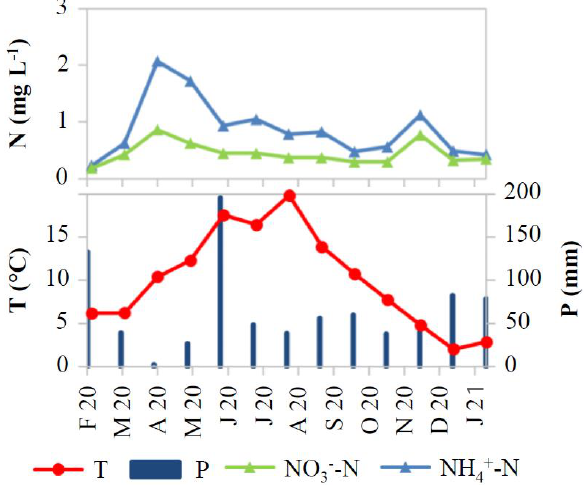
Figure 2. Precipitation (P), mean temperature (T) and concentrations of NH 4+ -N and NO 3- -N in precipitation samples over the course of the year.